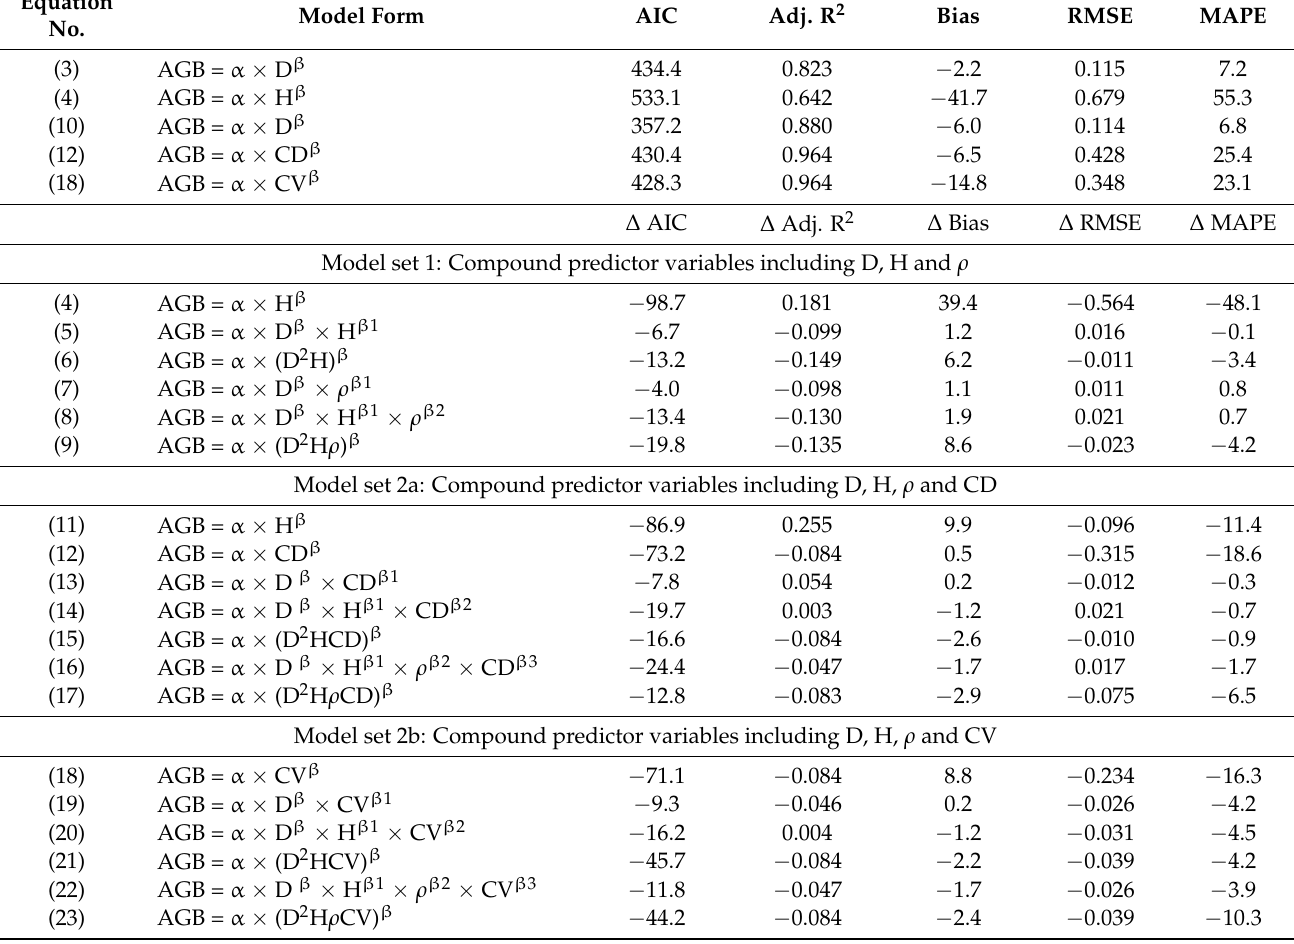
Table 5. The comparison of cross validation results when the model based on D alone (Equations (3) and (10)) was compared with models using different predictor variables. Equation (3) was compared with Equations (4)–(9), and (10) was compared with Equations (11)–(23). A negative change in AIC, RMSE and MAPE indicates that the D-based equation is better than others. A positive change in adj. R 2 means the model D-based is superior. We also present the five equations here (Equations (3), (4), (10), (12) and (18)) to estimate biomass directly from D, H, CD and CV.